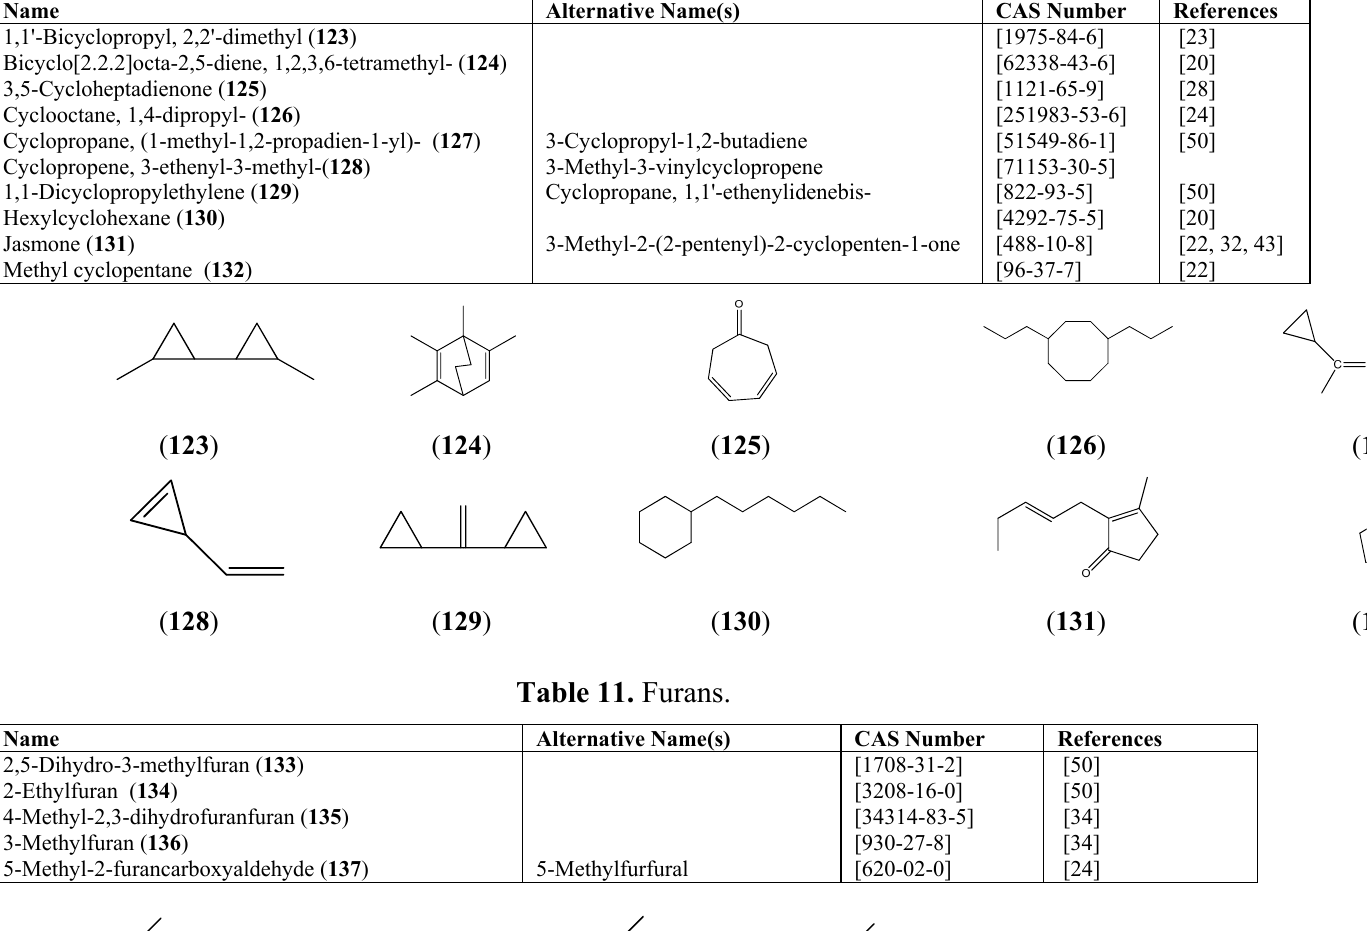
Table 10. Cyclic Hydrocarbons.